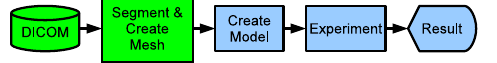
Fig. 1: Overview of tutorial. The input data is in DICOM format, and is processed in ScanIP+FE (green). The Model creation and experimenting are done in Multiphysics